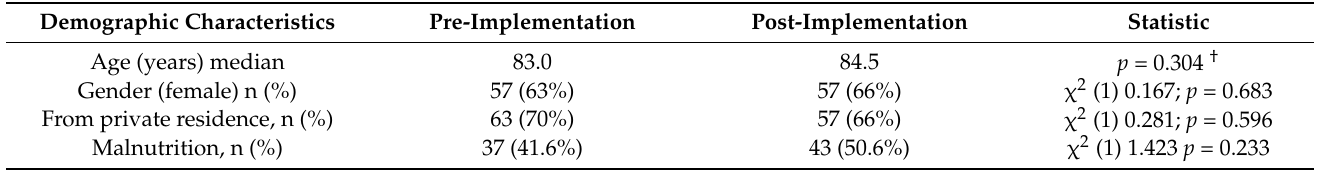
Table 2. Demographic Details of study patients.